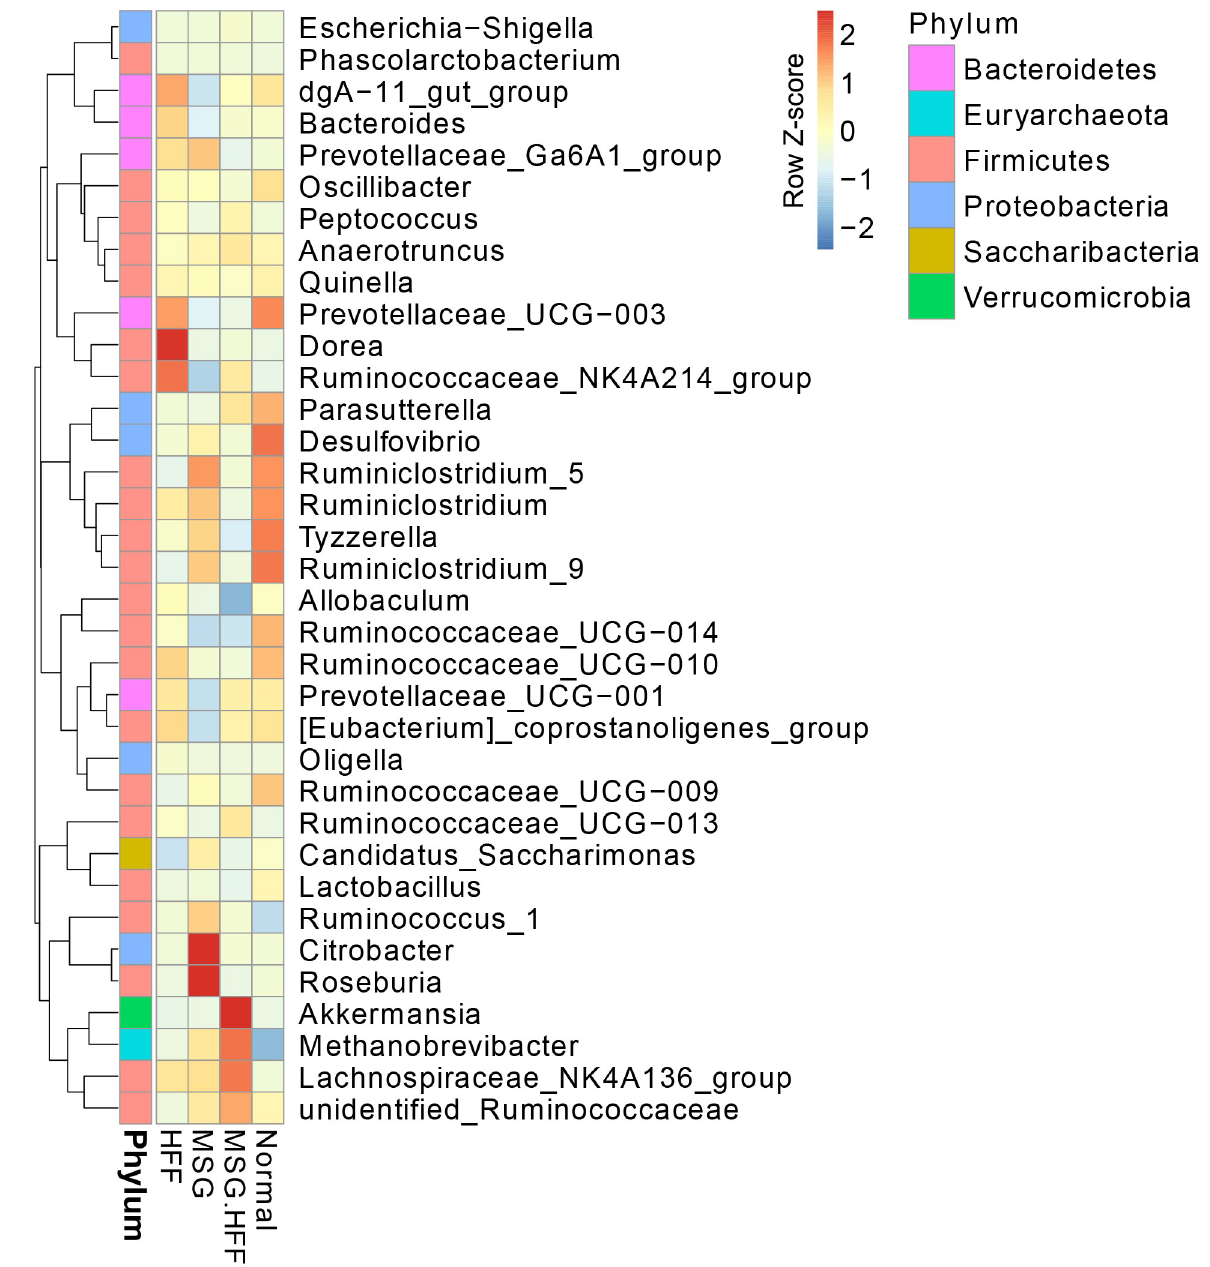
Fig 3. Composition of the gut microbiota. Heat map of the top 35 bacterial genera identified from hamster fecal DNA. The abundances were arranged using unsupervised hierarchical cluster analysis (blue, low abundance; red, high abundance).